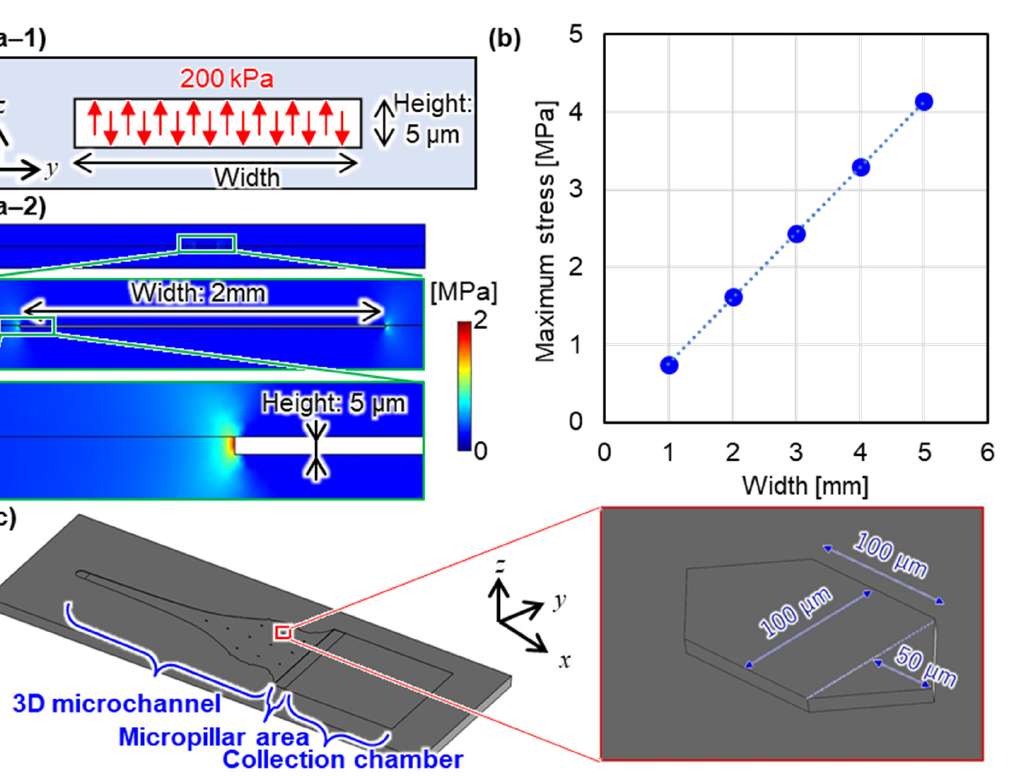
Figure 3. Design of the microchannel. ( a-1 ) Model configuration and ( a-2 ) Finite element method (FEM) image of the stress and ( b ) Analysis result of the relationship between the maximum stress and width of the microchannel. Considerations in the design of the microchannel. ( c ) Model config- uration of the microfluidic bioreactor, ( d ) Width of the designed microchannel, ( e ) Height of the designed microchannel, ( f ) FEM image of the stress, and ( g ) FEM image of the deformation of the designed microfluidic bioreactor.